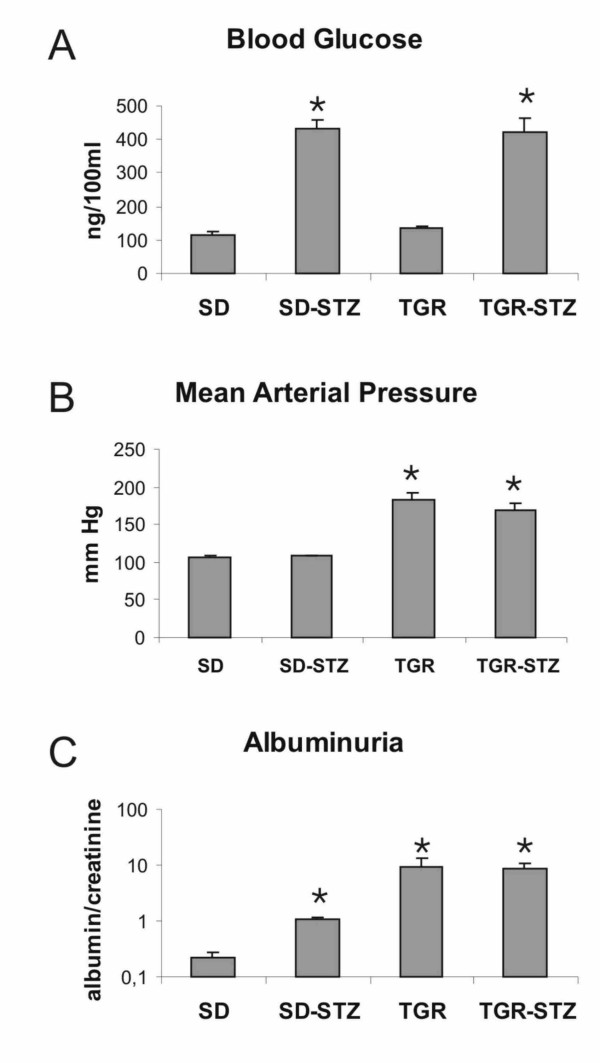
Blood glucose (panel A), arterial blood pressure (panel B) and albuminuria (panel C) of diabetic and hypertensive rats. Blood glucose was measured 24 hours before termination of the experiment. Mean arterial blood pressure was determined in awake rats via indwelling catheters inserted into the femoral artery. For determination of albuminuria, urine was collected 24 hours before sacrifice. SD, normotensive normoglycemic control rats; TGR, transgenic hypertensive rats; STZ, streptozotocin treatment. * indicates p < 0.05 versus normotensive normoglycemic SD control rats.